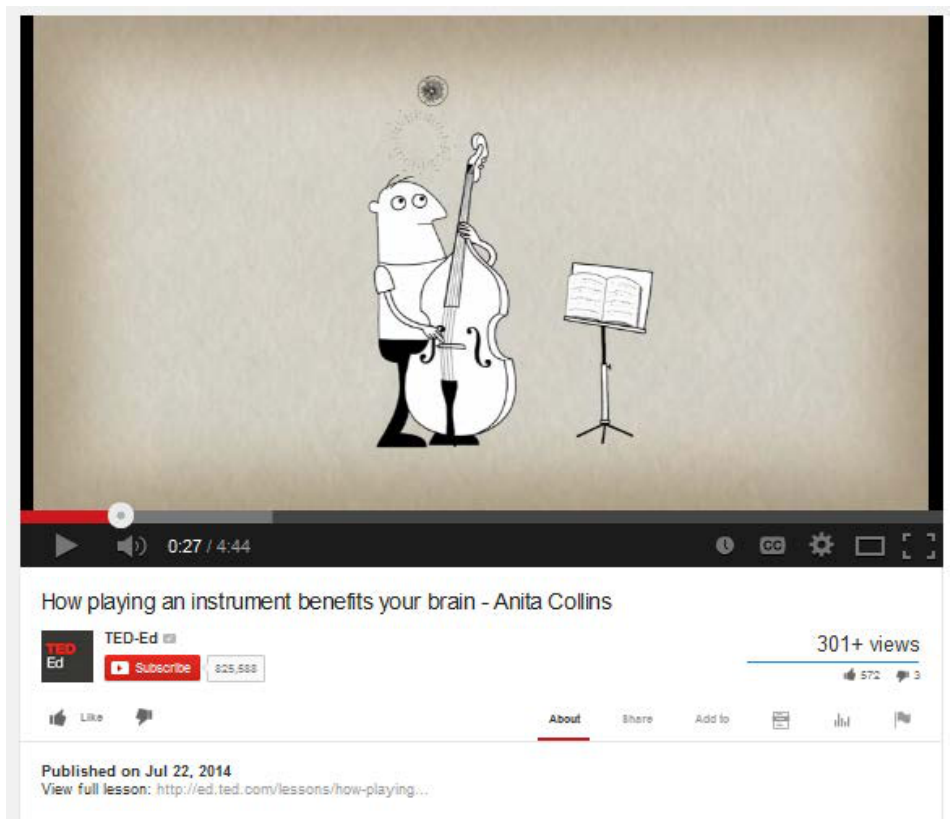
Figure 3. Example of TED-Ed video lesson viewed via